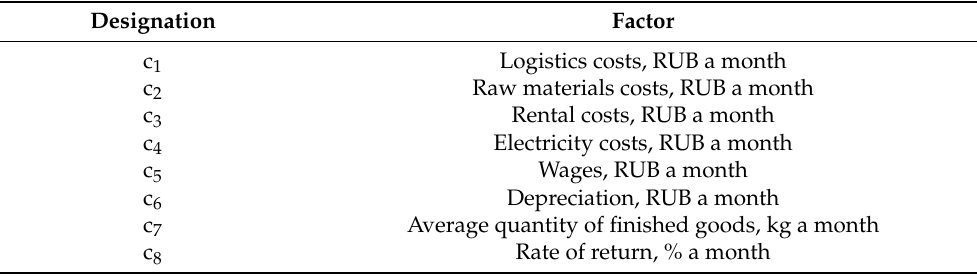
Table 10. Factors forming the prices for the goods produced by the